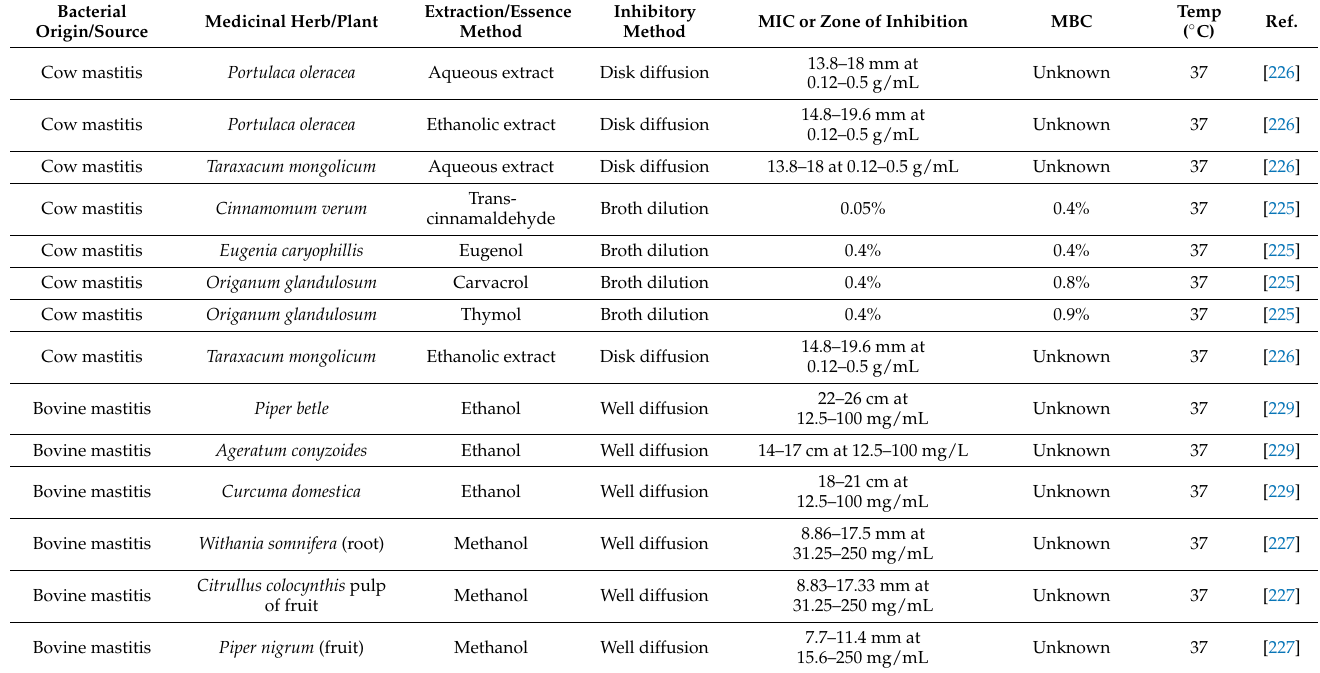
Table 5. In vitro inhibitory activity of medicinal/plants to S. dysgalactiae.